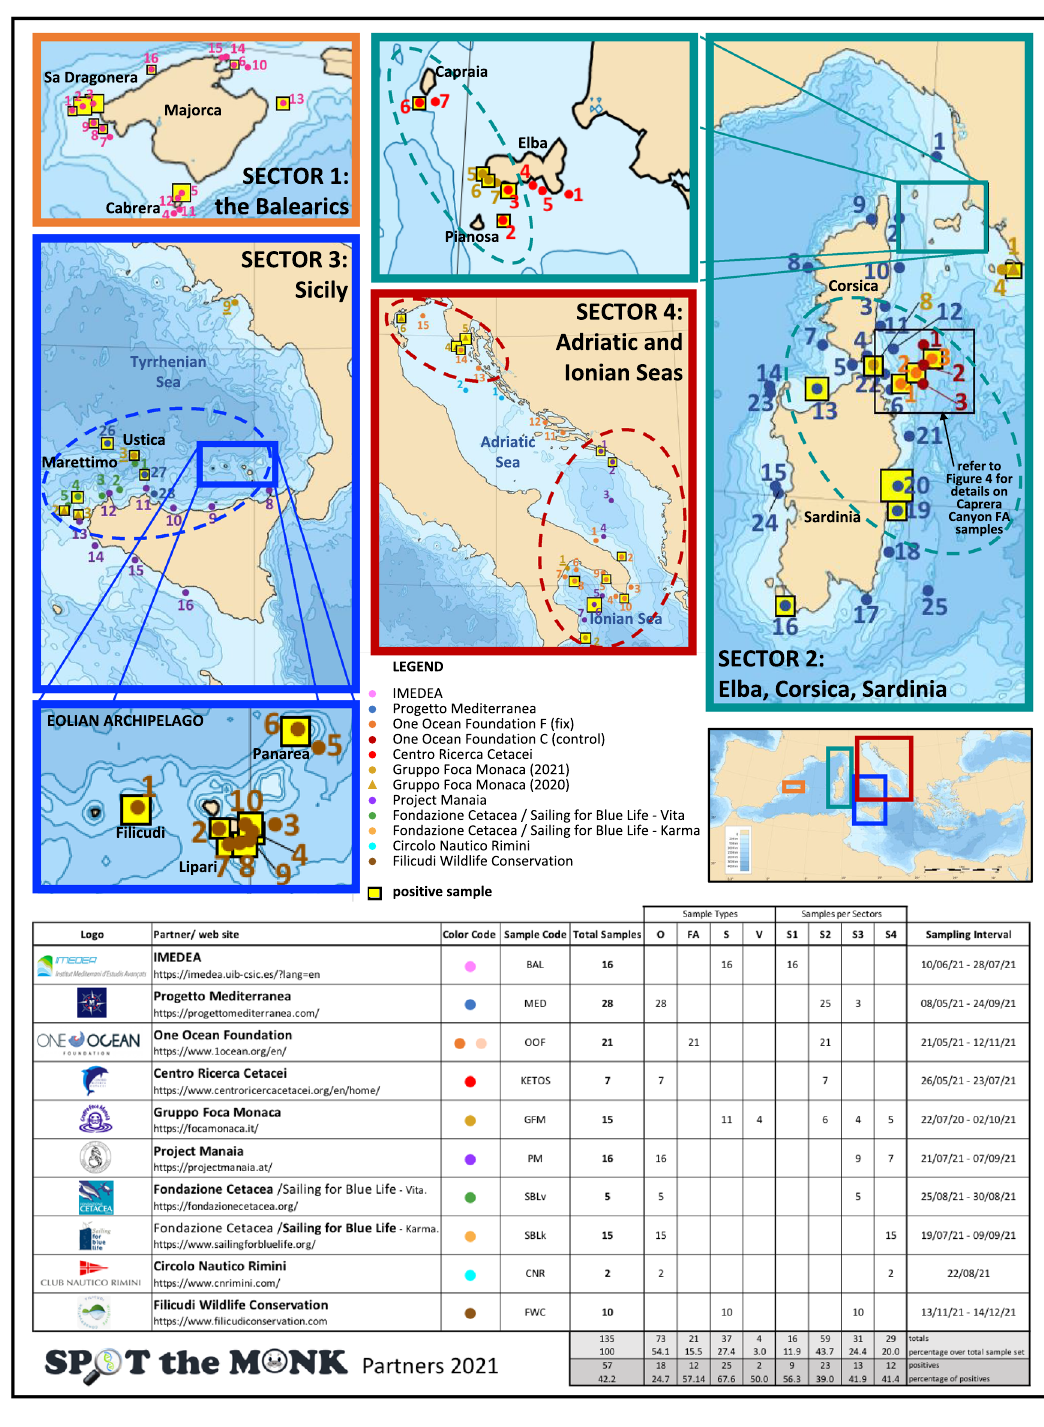
Figure 1. Maps of the four surveyed sectors showing the 120 points where samples (n=135) were collected. Sectors’ frames are colour-coded and their geographical position in relation to the Mediterranean Sea is shown in the map at the bottom right. For Sectors 2 and 3 a sub-map (with the same colour-code as the sector) is given to illustrate the samples taken from restricted areas. Sampling points surrounded by a yellow square indicate samples that tested positive for the presence of Monk Seal DNA in at least one of the experimental replicates: the size of the yellow square is proportional to the number of positive responses(the bigger it is the stronger the signal). The dashed lines delimit areas (hotspots) where multiple positive samples were observed and which would deserve continuous monitoring. The four underscored sample-numbers indicate V samples (validation samples) collected after a reported sighting, under the GFM coordination. The bottom table lists all the Spot the Monk partners contributing to the collection of samples, and their sampling effort (detailed per sample category, sector and sampling period). The Mediterranean Sea Bathymetry map was retrieved, and subsequently cropped, from https:// commo ns. wikim edia.